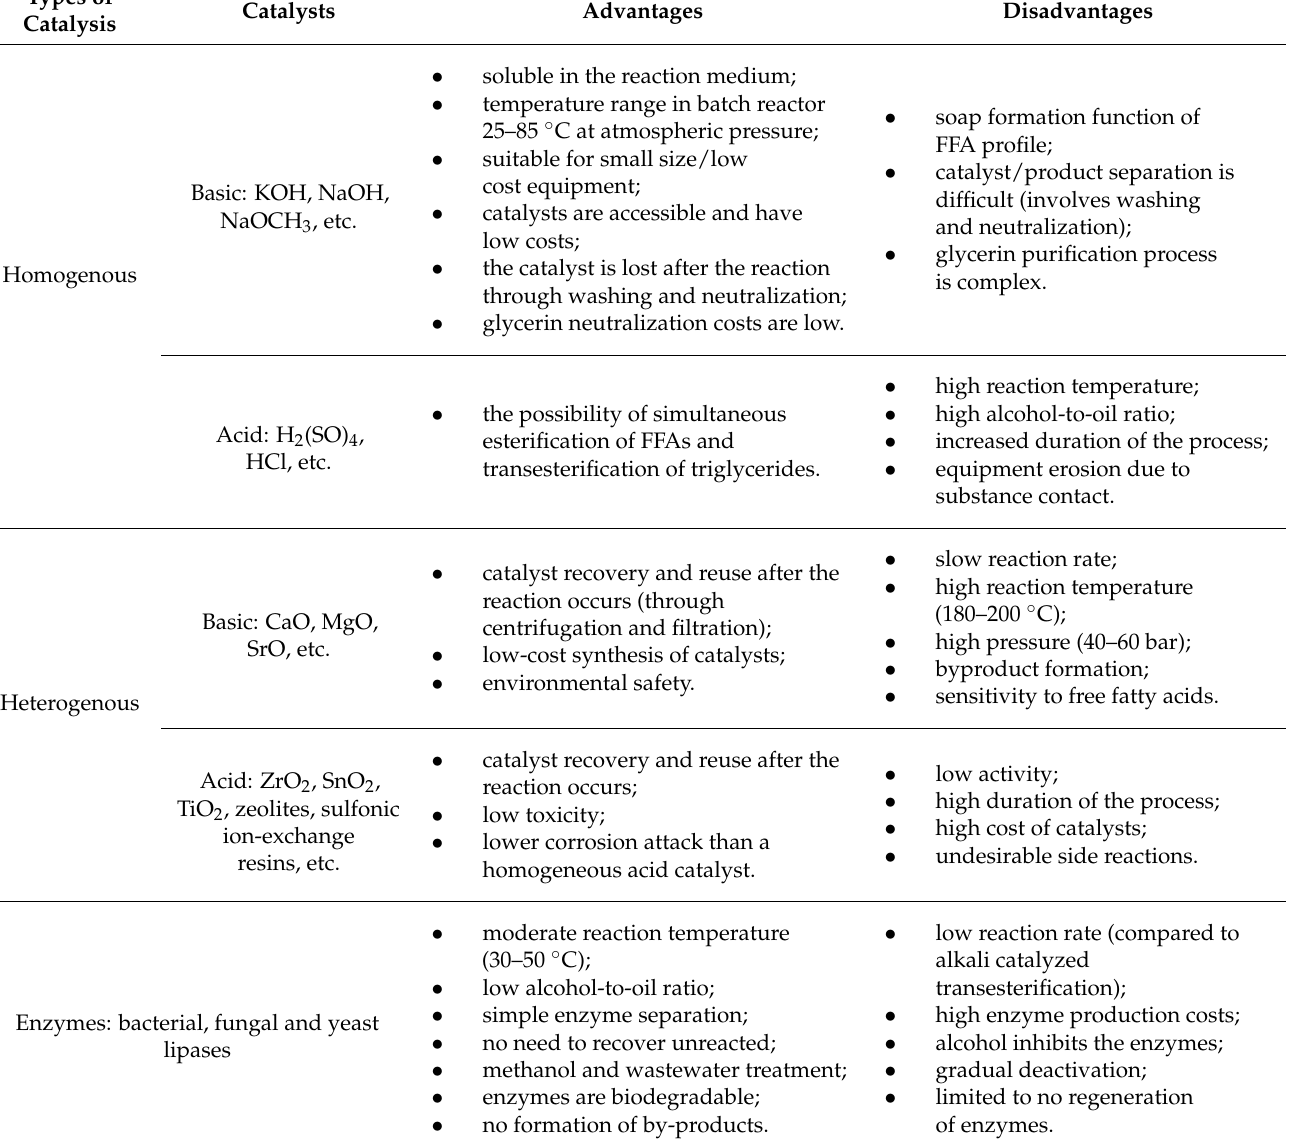
Table 1. Different types of catalysts used in the transesterification reaction for biodiesel production and their advantages and disadvantages